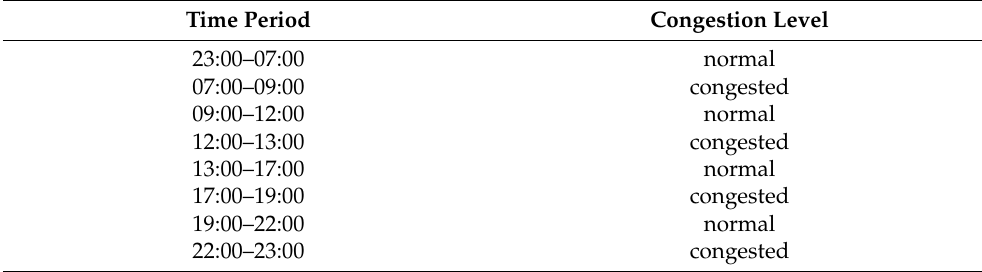
Table 2. Time period state interval.